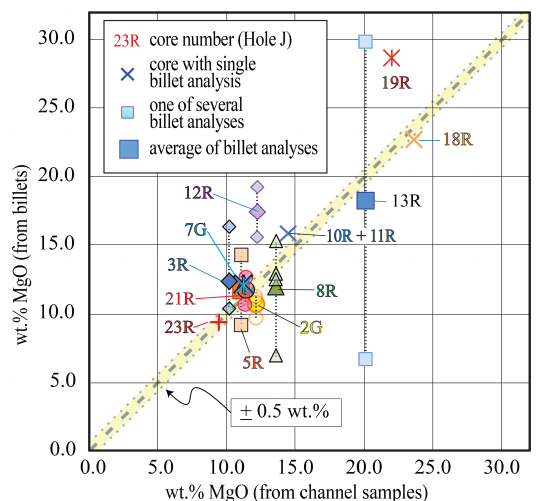
Figure 9. The comparison of bulk SiO 2 analyses of channel sam- ples ( x axis) from core from Hole J with the analyses of billets ( y axis) analyzed aboard the JR from the same cores. Where more than one billet was analyzed from a single core, they are joined by dotted vertical lines that correspond to the SiO 2 concentrations of the channel samples. Average compositions of the billets are in- dicated by the bolder symbols. The close correspondence among many samples shows a general agreement of the two sampling methods. However, the averages or single billet compositions of 6 out of 11 samples lie outside a 1.0wt% band (yellow), showing that average compositions of billets do not yield representative compo- sitions of the whole core.